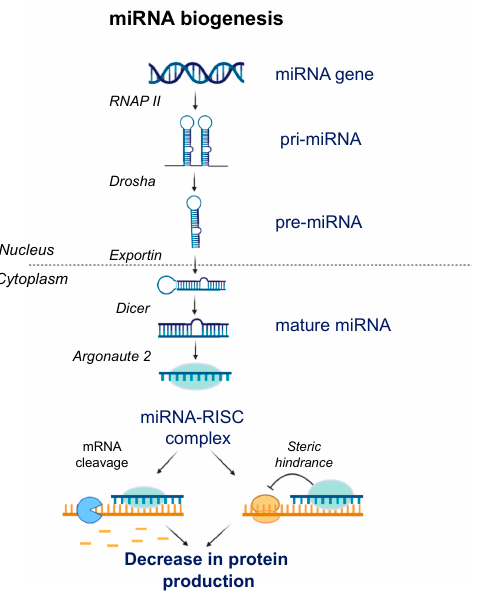
Figure 3. miRNA biogenesis and mechanism of action. miRNA is transcribed by RNA polymerase II (RNAP II) to form double stranded hairpin loop structure called pri-miRNA, which gets cleaved by nuclease Drosha to form pre-miRNA. Exportin transports the pre-miRNA to the cytoplasm where it is further processed by Dicer to form a single stranded mature miRNA. The mature miRNA is uploaded in the RNA induced silencing complex (RISC) where it associates with Argonaute 2 protein. This miRNA-RISC complex interacts with the seed region of the mRNA and regulates the mRNA translation by either mRNA cleavage or by steric hindrance.